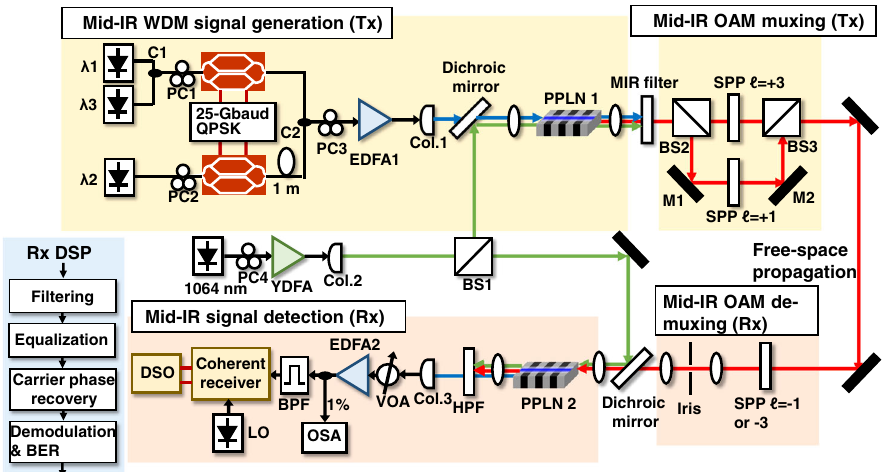
Fig. 2 | Experimental setup of the free-space mid-infrared WDM and MDM communication system. At the transmitter, C-band WDM signals are combined with a 1064nm pump and coupled into a PPLN waveguide. The generated mid-IR beamissplitintotwopathsandtransmittedthroughdifferentSPPstogeneratetwo OAM beams. At the receiver, an SPP with an inverse OAM order is used to convert one of the OAM beams back to the fundamental Gaussian beam. The converted beam is combined with the 1064nm pump and coupled into another PPLN